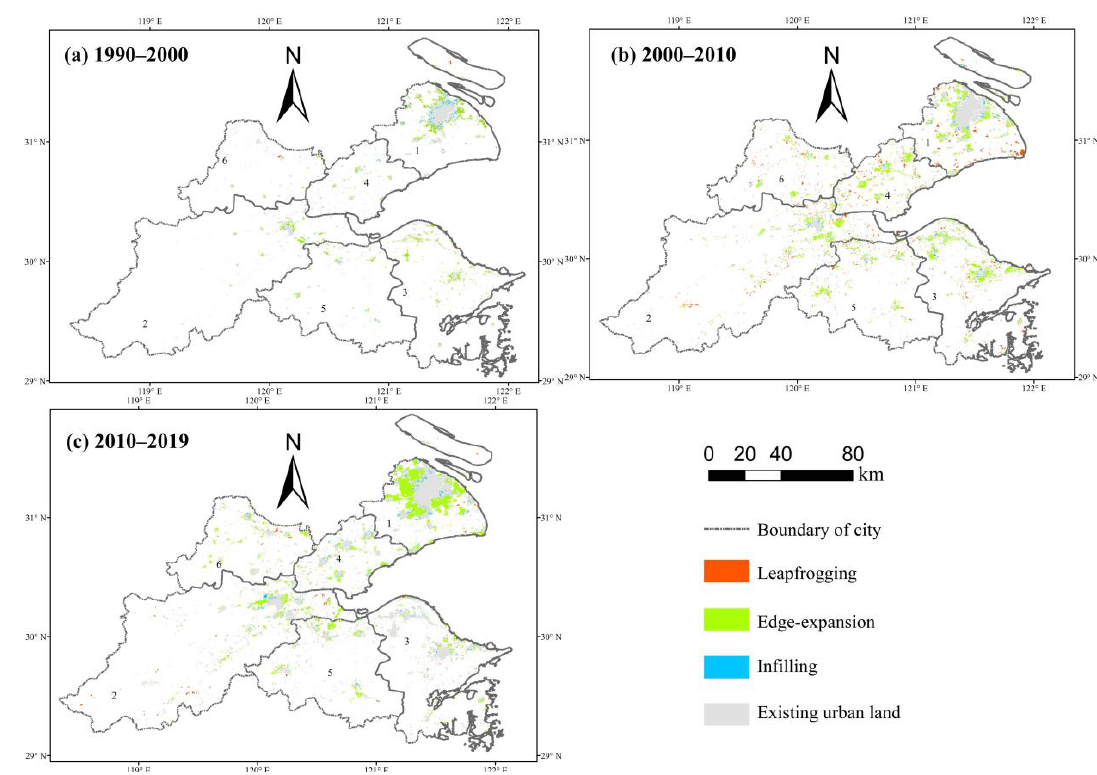
Figure 6. Spatial distributions of urban expansion forms in SHB from 1990 to 2019: ( a ). 1990 – 2000; ( b ). 2000 – 2010; ( c ). 2010 – 2019. Table 4. The proportion of urban expansion intensity levels for different urban expansion forms from 1990 to 2019